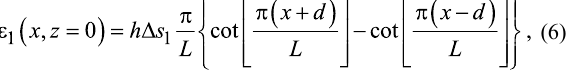
For surfaces with negative surface elastic constants Equation